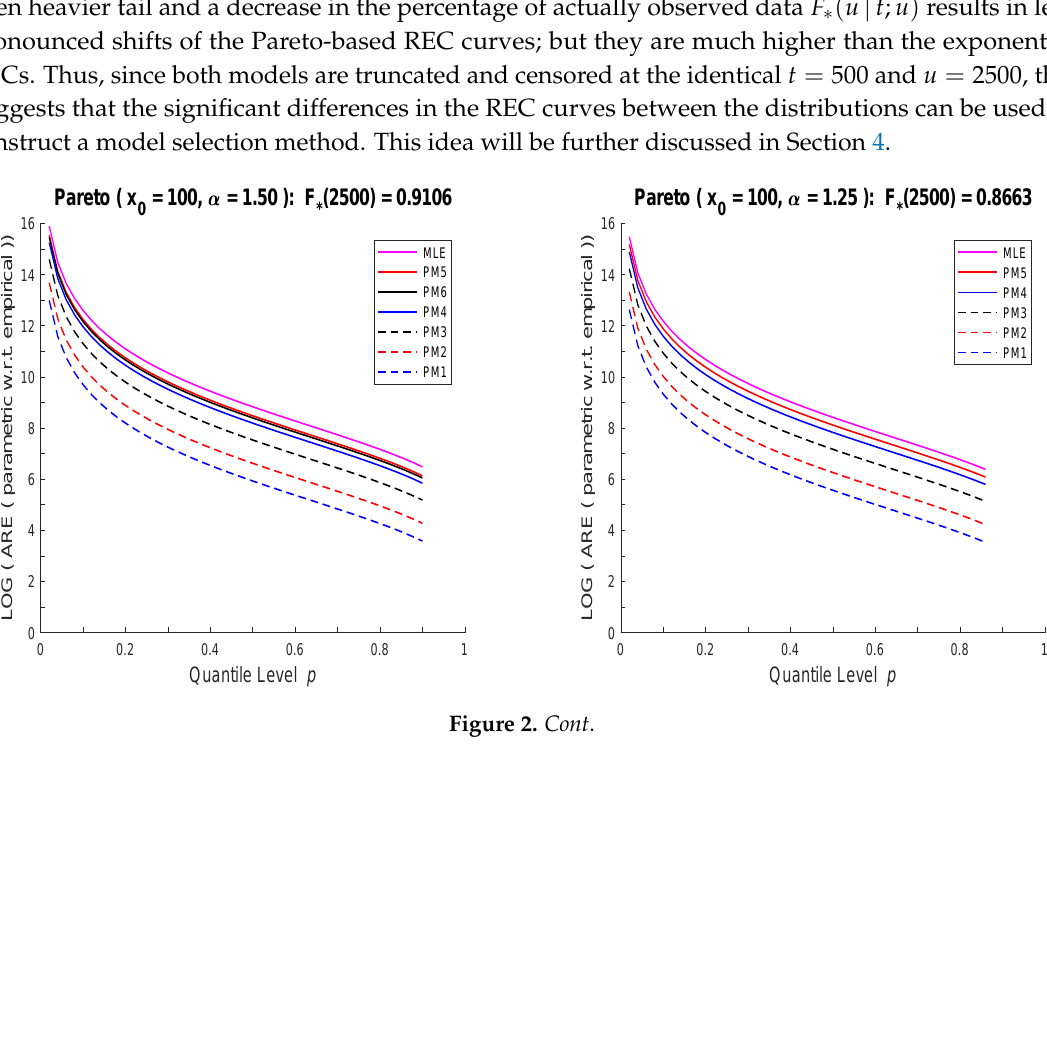
Figure 3.2. RECs of quantile estimators of the Pareto ( x 0 = 100 , α ) distribution for t = 500, u = 2500, n = 100, and α = 1 . 50 (left column), α = 1 . 25 (right column). Level p 1 = 0.05 ( pm 1 ), 0.10 ( pm 2 ), 0.25 ( pm 3 ), 0.50 ( pm 4 ), 0.75 ( pm 5 ), 0.90 ( pm 6 ). Top row : Plots of formulas (3.10) and (3.11). Bottom row : Plots of formula (3.12). 12